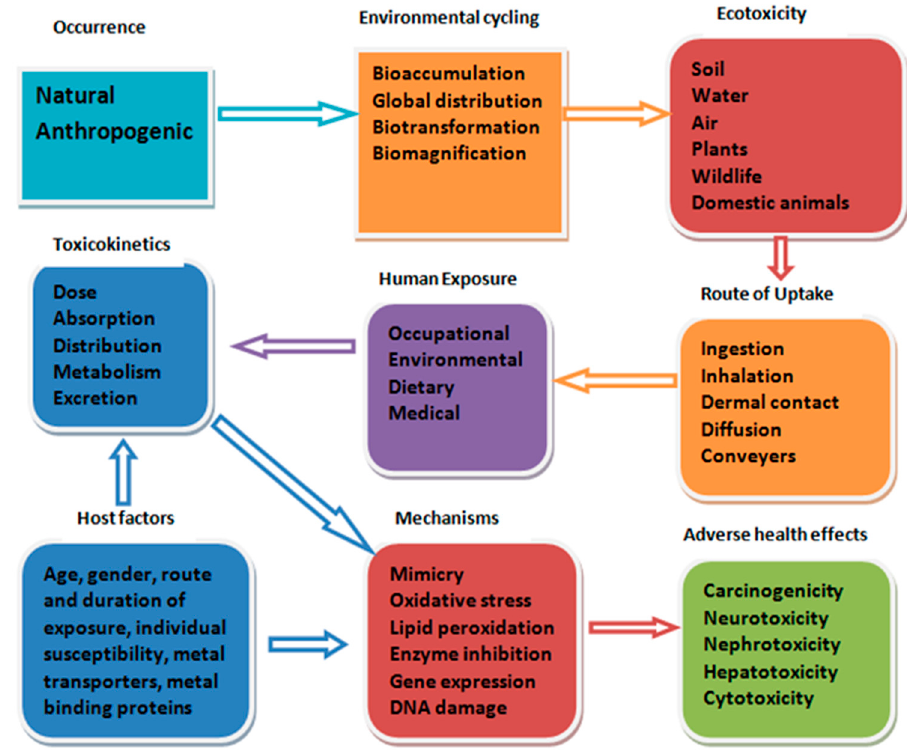
Figure 2. Conceptual framework of human exposure to heavy metal mixture from the environment.